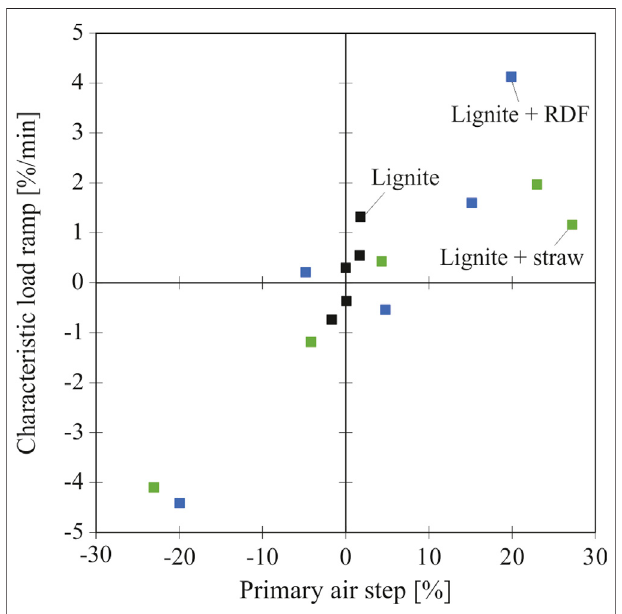
FIGURE 8 | In fl uence of the thermal load step on the response of the upper furnace